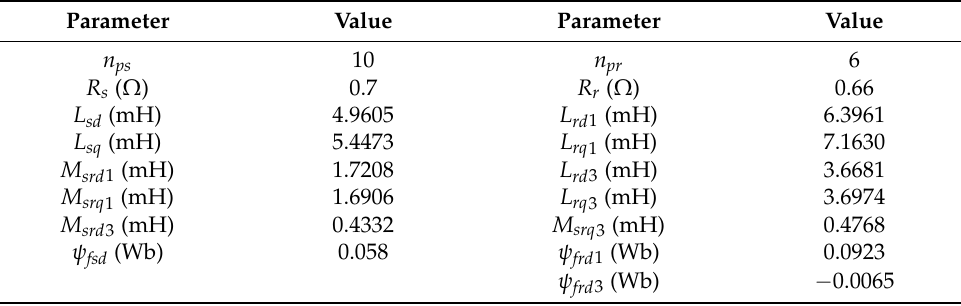
Table 1. Parameters of the DA-FSPM prototype.